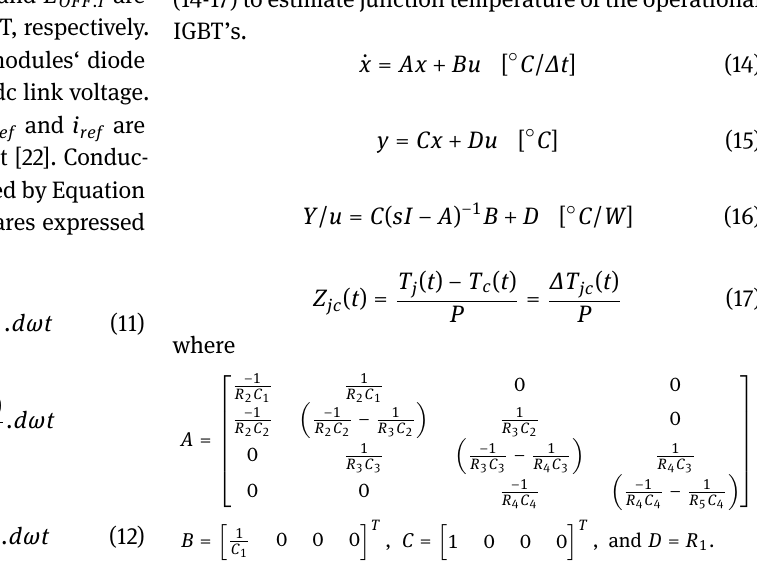
of VSC is given by Equation (10)